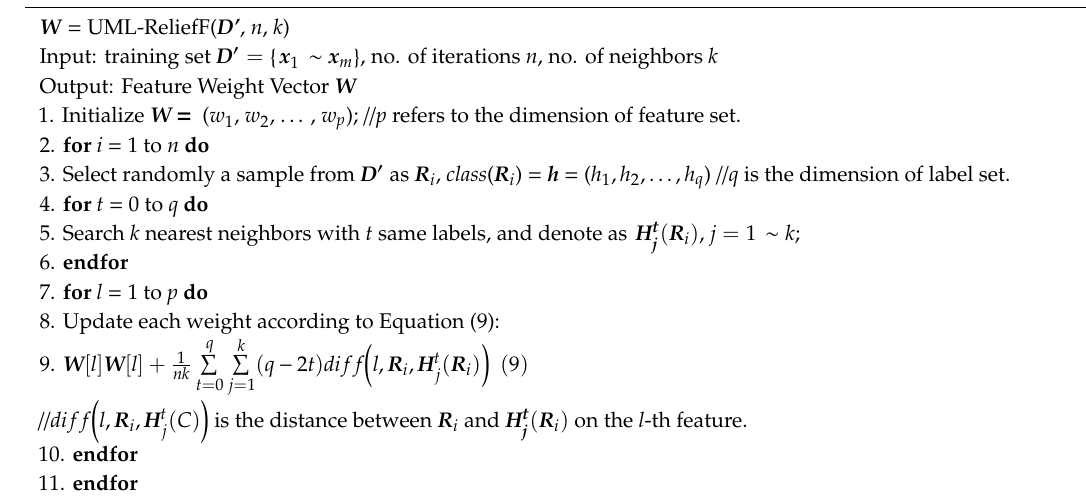
Algorithm 1. Pseudo code of unified multi-label ReliefF (UML-ReliefF) algorithm. W = UML-ReliefF( D’ , n , k